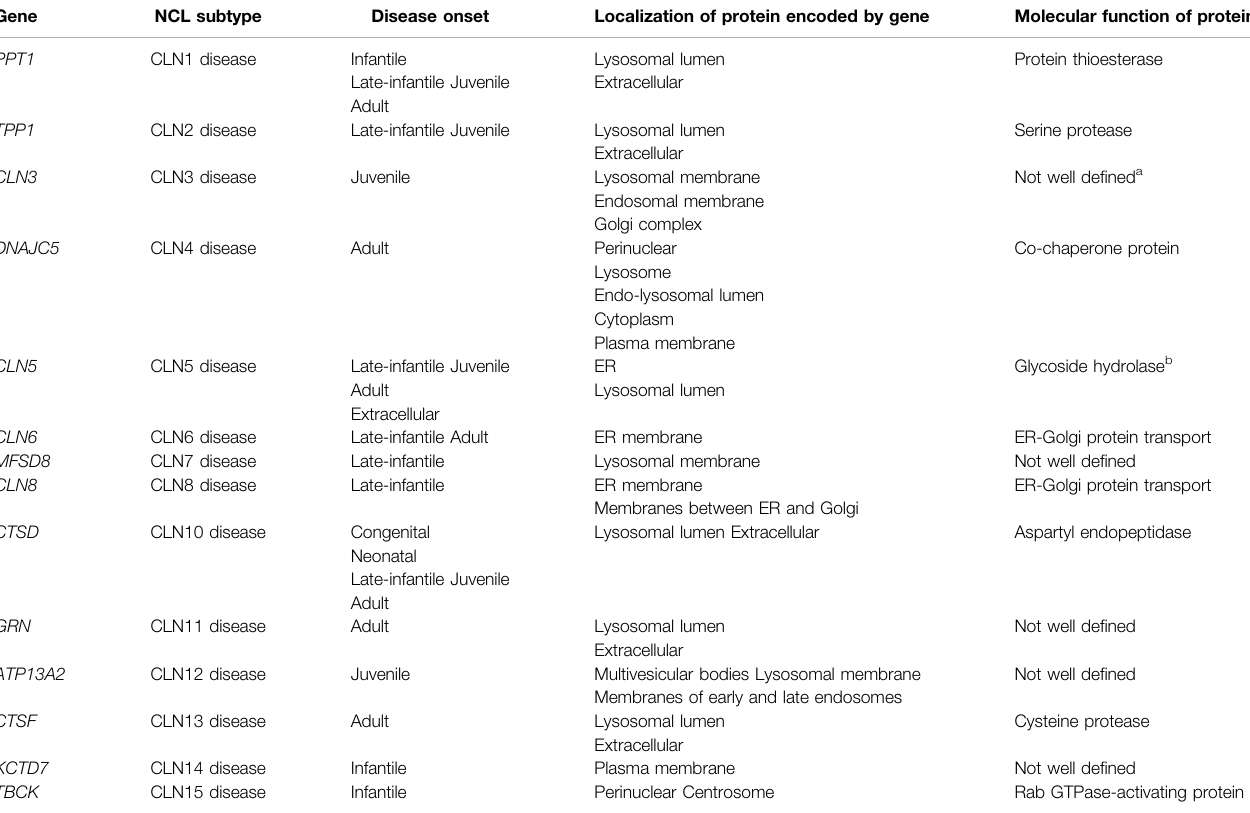
TABLE 1 | Genes associated with the NCL subtypes, as well as the localizations and molecular functions of proteins encoded by those genes.